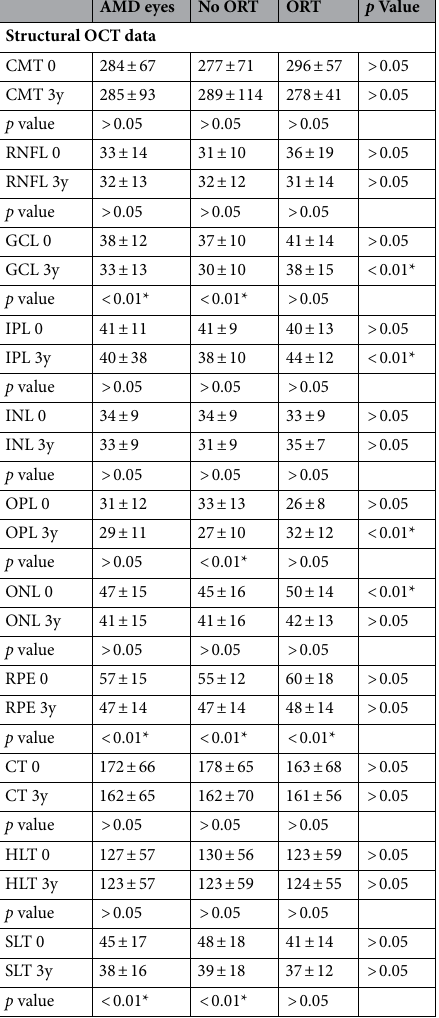
Table 2. Structural OCT data. The following abbreviations are used: outer retinal tubulations (ORT), age- related macular degeneration (AMD), central macular thickness (CMT), retinal nerve fiber layer